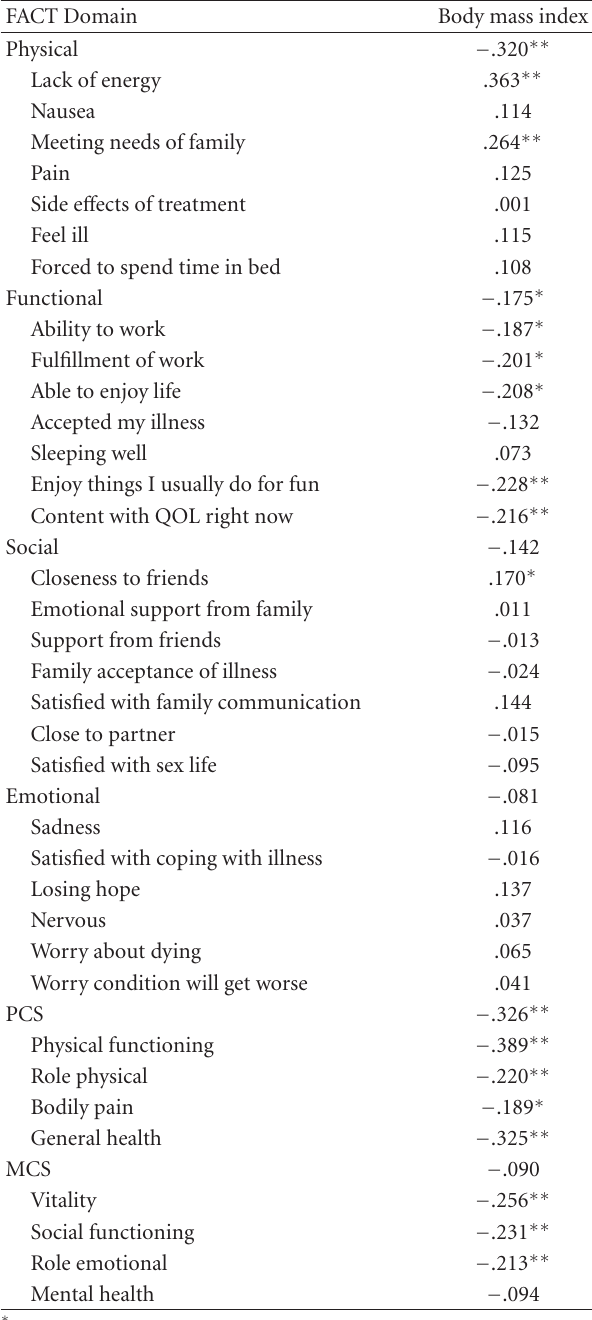
Table 3: Correlations between FACT domains, SF36 (PCS, MCS), and